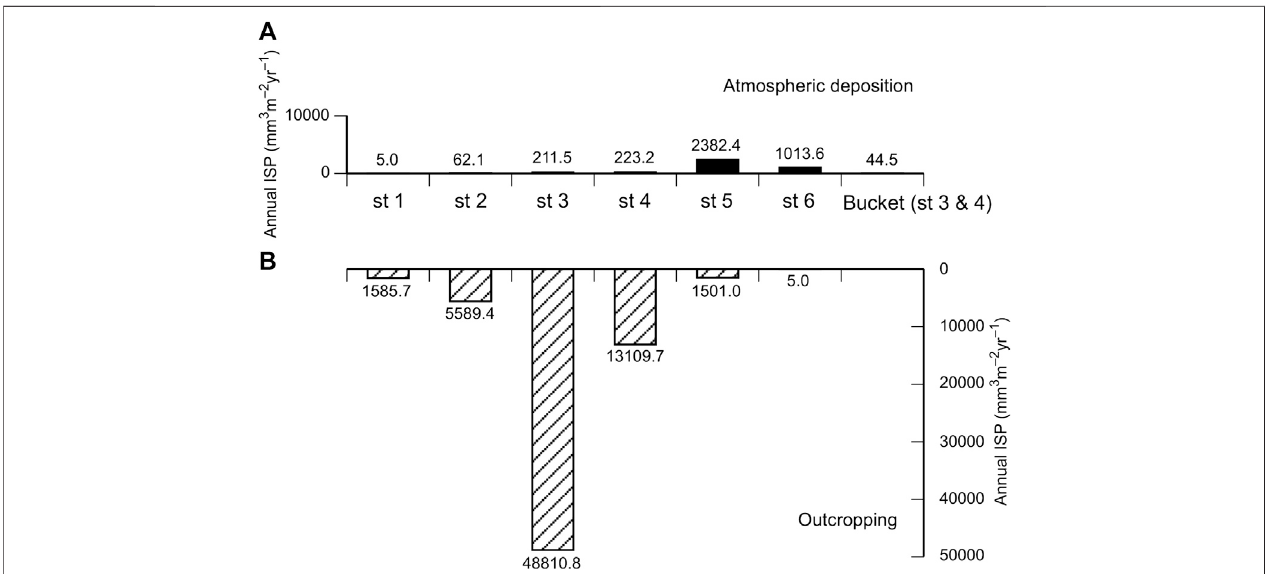
FIGURE 4 | (top) Annual fl ux of atmospheric ISP estimated from ISP concentration in seasonal snowpack in site 1 – 6 (st1 - st6), and from ISP concentration collected by bucket samplers set in sites 3 and 4 (right most). Value estimated by the bucket samplers is average of those in site 3 and site 4. Numbers of bar graphs indicate the estimated annual fl ux of atmospheric ISP (mm 3 m − 2 yr − 1 ). (bottom) Annual abundance of outcropping ISP at the surface of the glacier estimated by ISP concentrations in the glacier ice and annual surface mass balance at each site 1 – 6. Numbers of bar graphs indicate the estimated annual abundance of outcropping ISP (mm 3 m − 2 yr − 1 ) in each site.